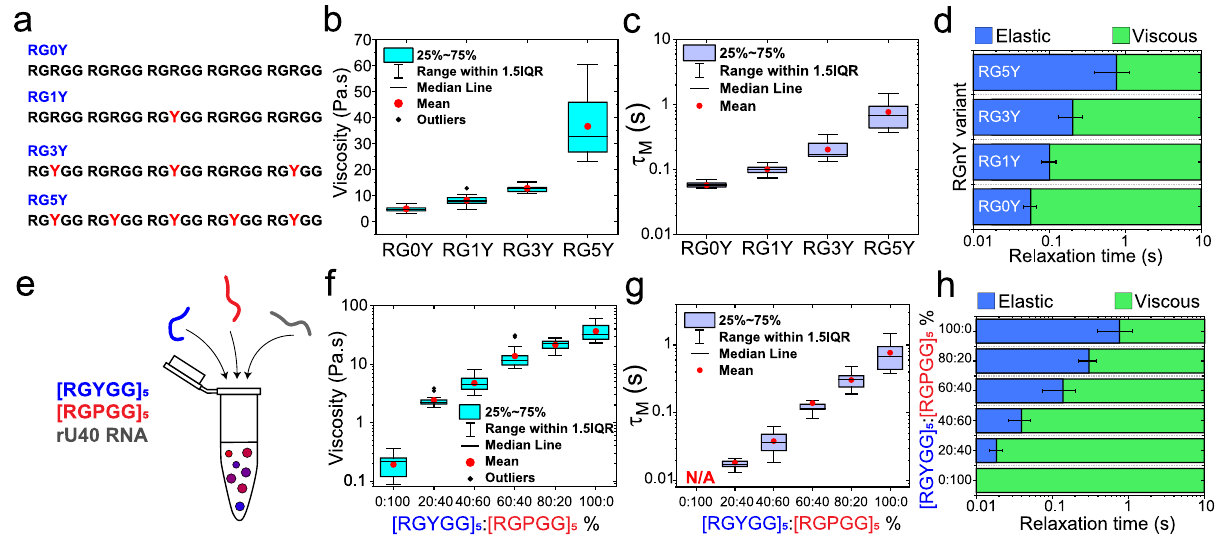
Fig. 5 Continuous tuning of LVE behavior of peptide-RNA condensates by two orthogonal approaches. a Polypeptide sequences of the RG n Y peptide design with n representing the number of Tyr residues. RG0Y corresponds to [RGRGG] 5 , RG5Y corresponds to [RGYGG] 5 (see Supplementary Table 1). b The zero-shear viscosity of RG n Y-rU40 condensates as measured by pMOT. c The terminal relaxation time τ M of RG n Y-rU40 condensates as measured by pMOT (see Supplementary Fig. 10). d An experimental LVE state diagram indicating the timescales at which the elastic modulus dominates (blue) and the timescales where the viscous modulus dominates (green) in RG n Y-rU40 condensates. Error bars represent one standard deviation (±1 s.d.). e A scheme showing the preparation of condensates formed by mixing [RGYGG] 5 , [RGPGG] 5 , and rU40 RNA with variable [RGYGG] 5 -to-[RGPGG] 5 ratios. Here, the total peptide concentration is fi xed at 5.0 mg/ml and the relative fractions of [RGYGG] 5 and [RGPGG] 5 are varied. f The zero-shear viscosity of condensates formed by mixtures of [RGYGG] 5 , [RGPGG] 5 , and RNA at variable [RGYGG] 5 -to-[RGPGG] 5 ratios. g The terminal relaxation time ( τ M ) of the same condensates as in f . See Supplementary Fig. 12 for the viscoelastic moduli. h An experimental LVE state diagram indicating the timescales at which the elastic modulus dominates (blue) and the timescales where the viscous modulus dominates (green) in [RGYGG] 5 -[RGPGG] 5 -rU40 condensates as a function of [RGYGG] 5 -to-[RGPGG] 5 ratio. Error bars represent one standard deviation (±1 s.d.). For b – d , the sample size is n = (17,20,10,16) for (RG0Y, RG1Y, RG3Y, RG5Y), respectively. For g – h , the sample size is n = (29,14,36,18,18,16) for [RGYGG] 5 fractions of (0%,20%,40%,60%,80%,100%),